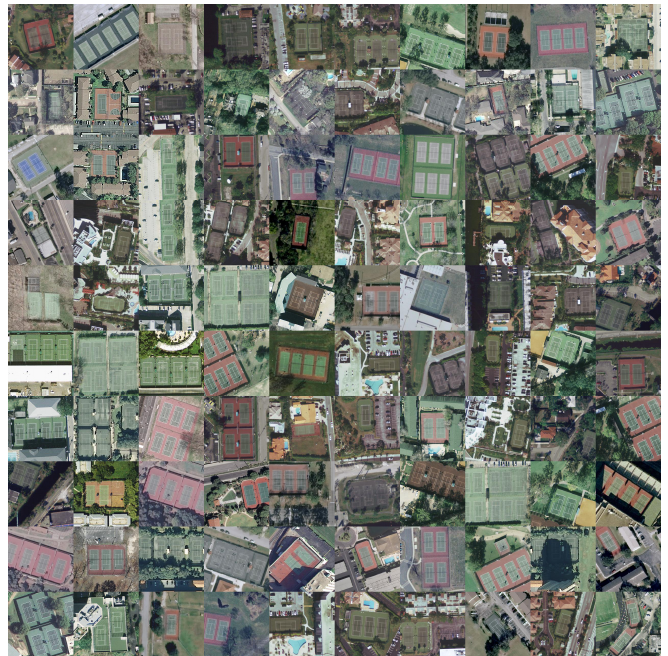
Figure 4. Ground truth for remote sensing images of tennis courts in UCMerced LandUse. There are 100 images of tennis courts in total.